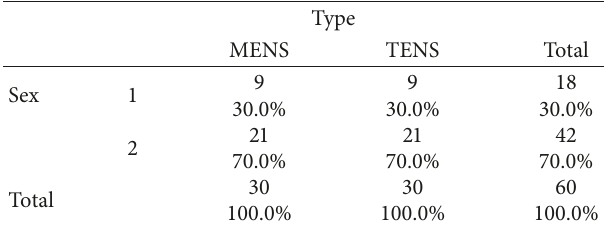
Table 1: Genderwise distribution of masticatory muscle pain among the study population. Males are represented by 1 and fe- males by 2.